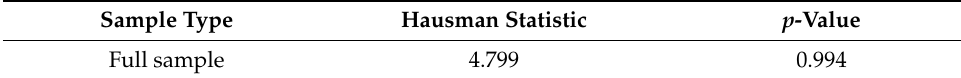
Table 3. Hausman test result of the full sample of Model